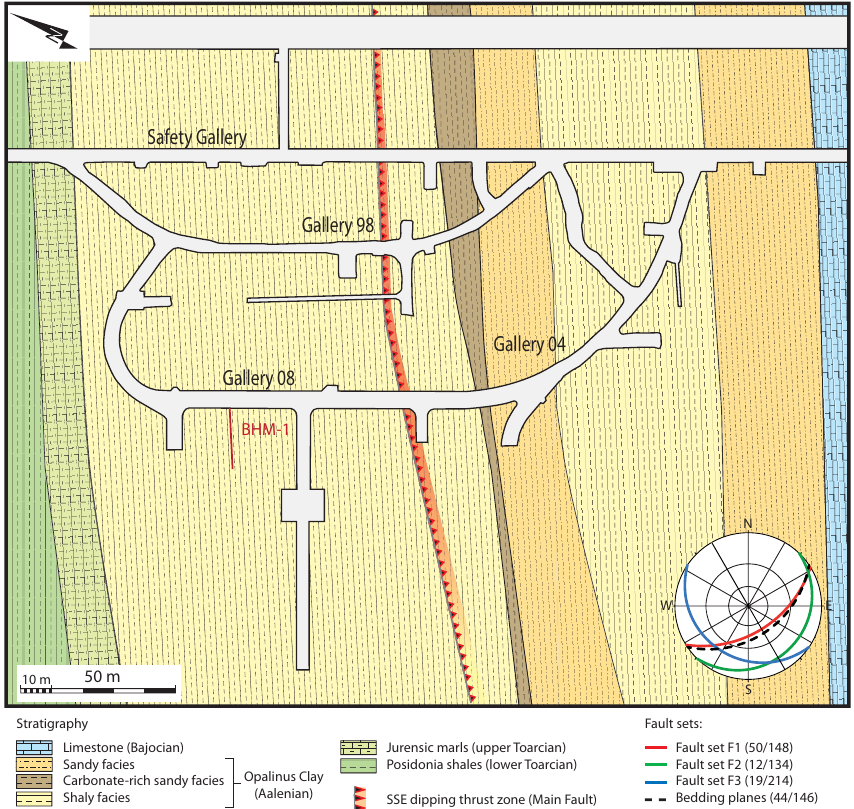
Figure 1. Geological map of the Mont Terri URL (modified from Nussbaum et al., 2011). The specimens used in this study were obtained from the borehole BHM-1 that was drilled parallel to bedding in Gallery 08. The location of the borehole is indicated